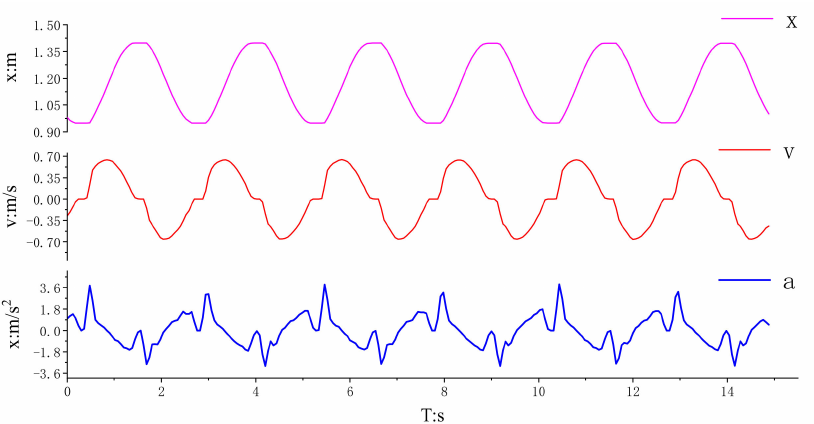
Figure 21. Hydraulic cylinder displacement–velocity–acceleration test curve. x denotes hy- draulic cylinder displacement; v denotes the hydraulic cylinder speed; a denotes the hydraulic cylinder